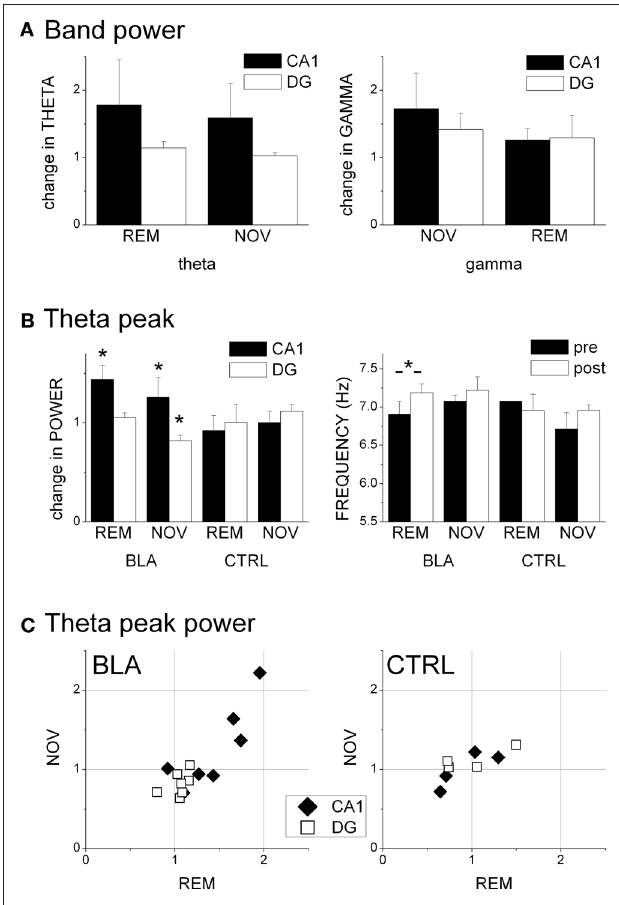
FiguRE 5 | Effect of picrotoxin injection in the BLA on hippocampal oscillations during REM sleep and novelty exploration. (A) Change in spectral power in the theta (5–10 Hz) and gamma (30–50 Hz) frequency ranges in CA1 and DG regions, expressed as ratio of average band power before and on the 4th day after BLA injection. (B) Characteristics of the theta peak of the average spectra. Theta frequency is shown in absolute values, theta power is expressed as pre- post-injection ratio. (C) Changes in theta power in REM and NOV after BLA (left) and control injections (right) of picrotoxin in individual